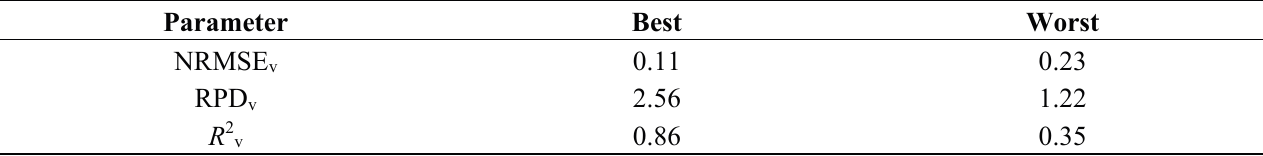
Table 8. Validation criteria for the best and worst neural network with 10 neurons in the middle layer.